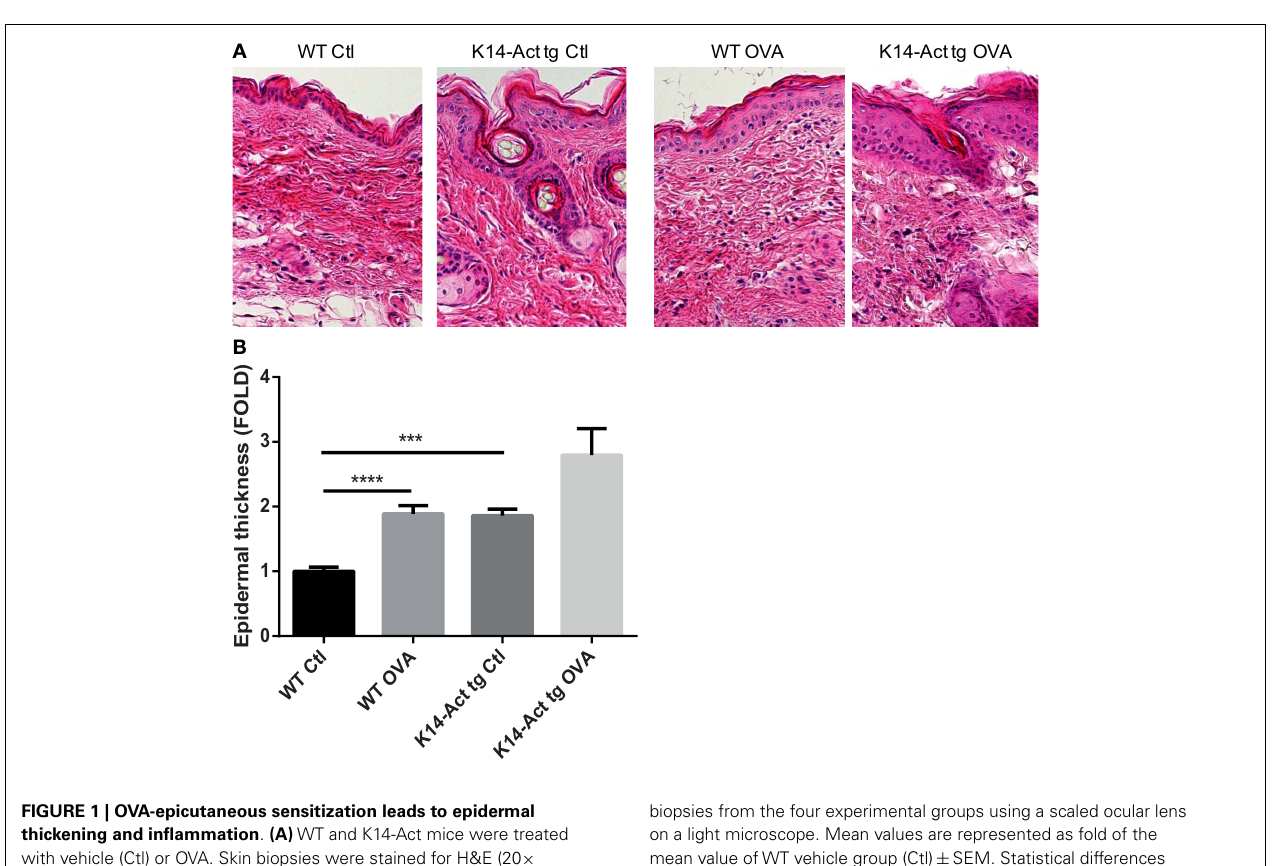
FIGURE 1 | OVA-epicutaneous sensitization leads to epidermal thickening and inflammation . (A) WT and K14-Act mice were treated with vehicle (Ctl) or OVA. Skin biopsies were stained for H&E (20 × objective). (B) Epidermal thickness (7–10 animals per group, five to seven fields per animal) in micrometer was measured on H&E-stained